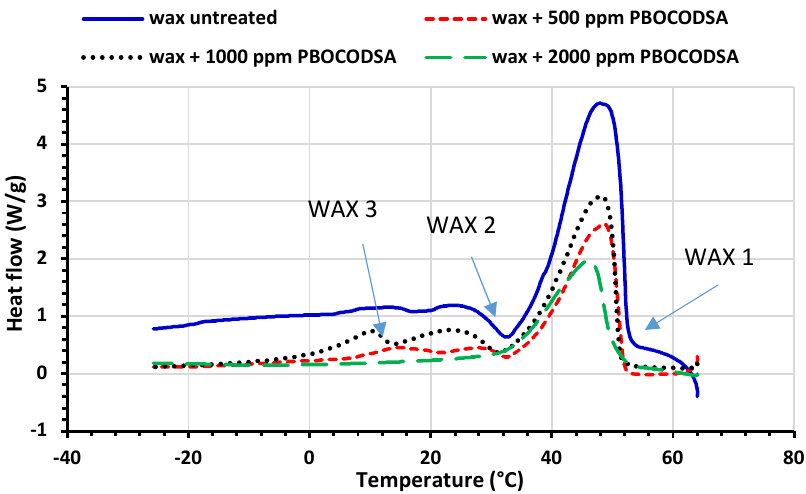
Figure 5. ( a ) Relation between shear rate and apparent viscosity for crude oil treated with PBOCODSA (500, 1000, and 2000ppm) at 15, 24, and 30 °C. ( b ) Relation between shear rate and shear stress for crude oil treated with PBOCODSA (500, 1000, and 2000 ppm) at 15, 24, and 30 °C.